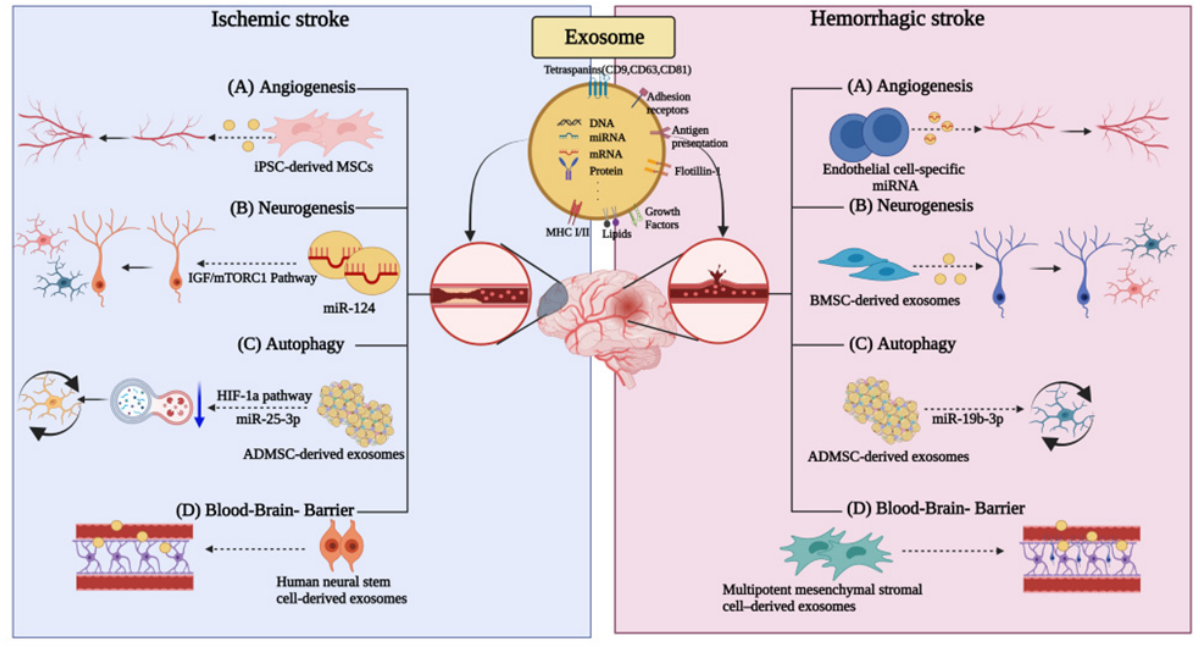
Figure 2. Exosomes are involved in different ways in ischemic and hemorrhagic strokes. Different roles of exosomes in ( A ) angiogenesis, ( B ) neurogenesis, ( C ) autophagy, and ( D ) blood–brain-barrier in ischemic stroke and hemorrhagic stroke.